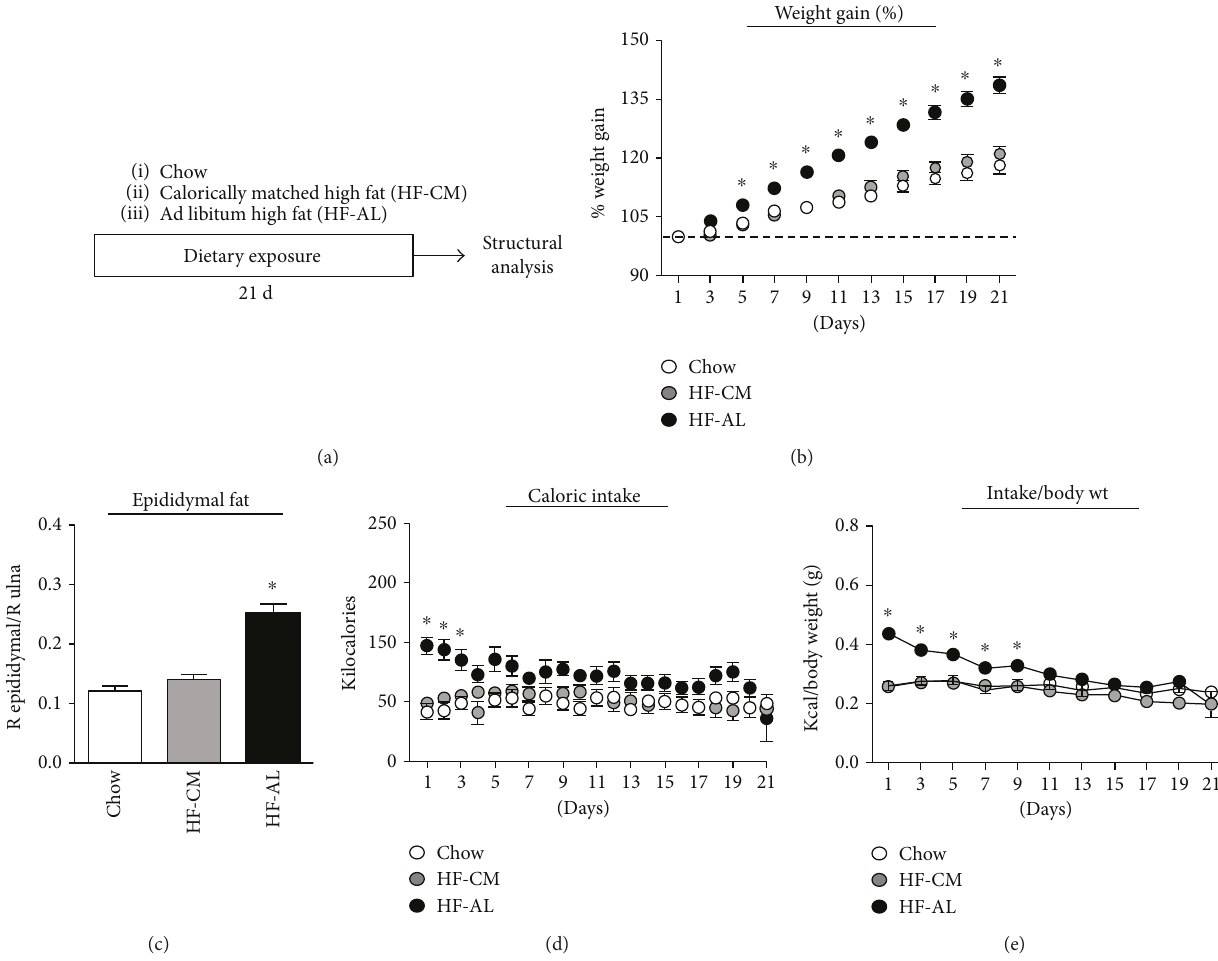
Figure 1: Dietary manipulation. (a) Experimental timeline. Animals were fed with one of three dietary conditions for 21 days, and then tissues were immediately extracted and analyzed. (b) Percent weight gain from baseline in chow (white), HF-CM (gray), and HF-AL (black) groups. (c) Approximate body fat accumulation, expressed as the weight of the right epididymal fat pad over the length of the right ulna bone. (d) Caloric intake across the dietary manipulation. (e) Food consumption expressed as the ratio of kilocalories consumed to body weight. Values represent the mean ± SEM ( ∗ p < 0 05